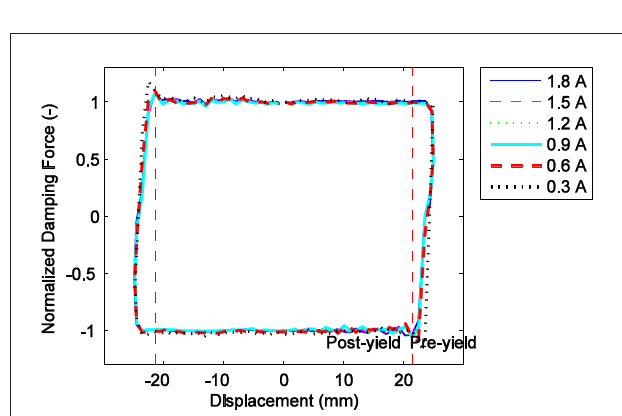
FIGURE 3 | Mechanical behavior of the MR damper with 1.8A current under triangle displacement excitations with different frequencies and an amplitude of 25mm.